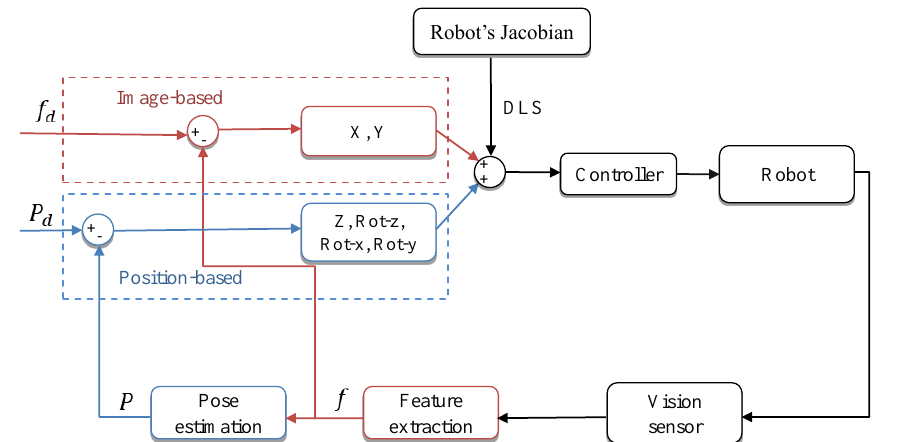
Figure 3. The control schema of the proposed visual servoing approach (DHVS).